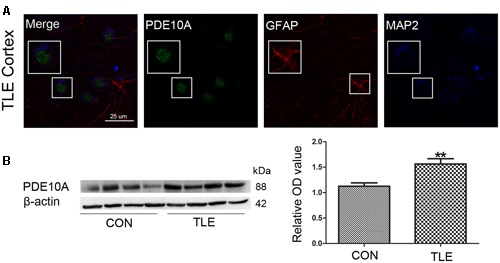
PDE10A expression in the temporal cortex of TLE patients. (A) Triple-label immunofluorescence demonstrated that PDE10A (green) and GFAP (red) were not co-expressed in astrocytes, but PDE10A (green) and MAP2 (blue) were co-expressed in the neurons of patient cortex (n = 10). The white squares indicate positive cells. (B) Representative Western blots revealed PDE10A expression in TLE patients and controls. The mean OD ratio of PDE10A relative to β-actin was significantly higher in the TLE group compared with the control group (**P < 0.01).